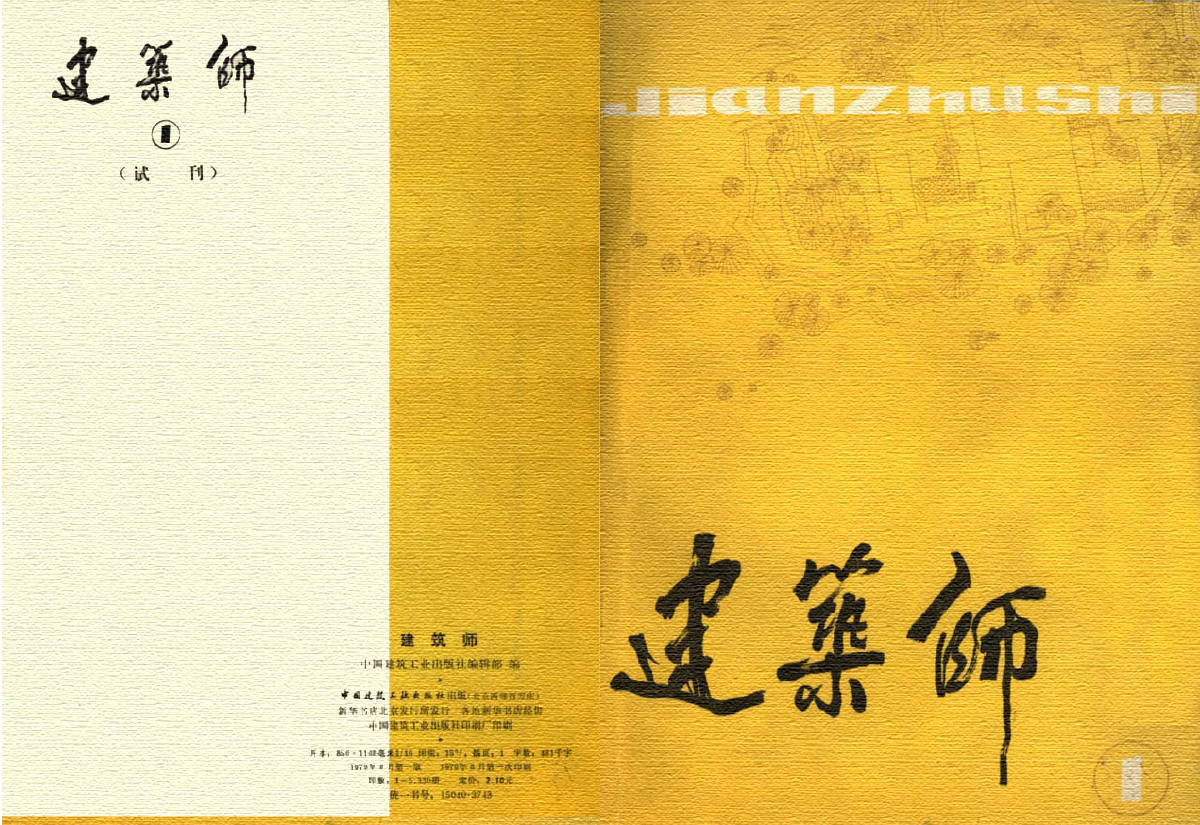
The cover of Jiànzhúshī , 1979, no.